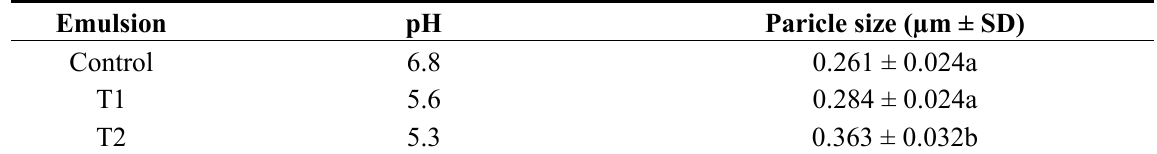
Table 2. Emulsion droplet size obtained for emulsions treated with whole cranberry extract